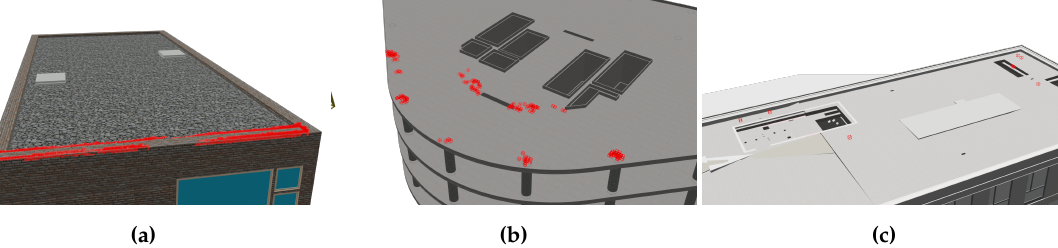
Figure 10. Results of false positive tests (scenario 2). Objects from Figure 9 are required by the schedule but missing in the as-built scenes. Red annotations show parts of the inspection object being matched erroneously. ( a ) Several false positives occurred closely above the top face of another wall object (12.74%). ( b ) Some false positives above neighbouring columns (2.32%). ( c )Few false positives with seemingly random distribution